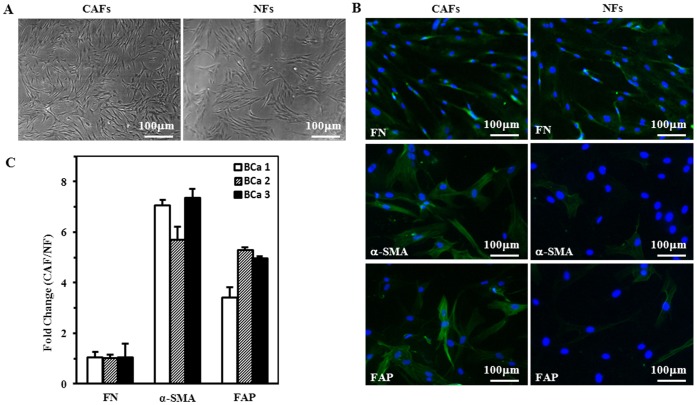
Characterization of fibroblasts isolated from human breast tissue samples.A. Representative cell morphology of CAFs and NFs. B. Identification of CAFs using fibroblast biomarker fibronectin, and CAFs specific biomarker α-SMA and FAP by immunofluorescence staining. C. The biomarker gene expression in CAFs and NFs was re-proved by qTR-PCR, and its relative fold change in CAFs and NFs was displayed. The CAFs and NFs are positive for fibroblast biomarker fibronectin, CAFs specific biomarker α-SMA and FAP are high expression in CAFs (magnification 100× (cell morphology); 200× (Biomarker immunofluorescence staining).